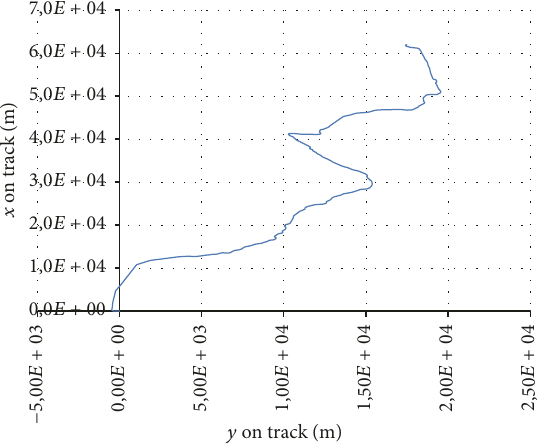
Figure 16: Layout of the track in the horizontal plane.